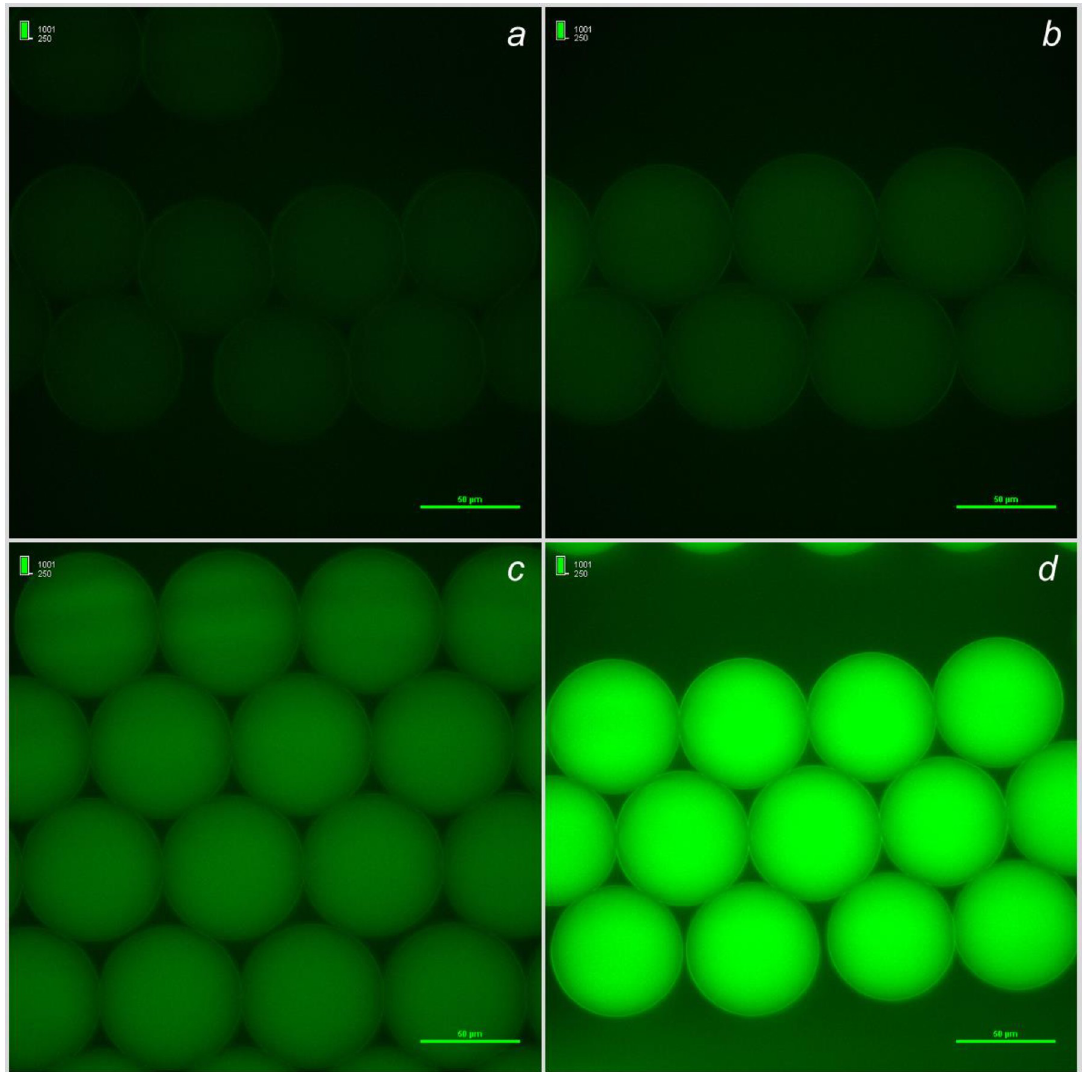
Fig 2. Medium and FITC-Ab were encapsulated in 50–70 μ m diameter droplets (1x medium and 0.83 μ g/ml FITC-Ab in-droplet) to visually assess medium contribution to fluorescence. Fluorescence exposure and look-up-table (LUT) settings are standardized across all four media evaluated. The LUT values can be found in the upper left-hand corner of each image. Media under test included phosphate buffered saline (a), Rappaport-Vassiliadis (b), buffered peptone water (c), and tryptic soy broth